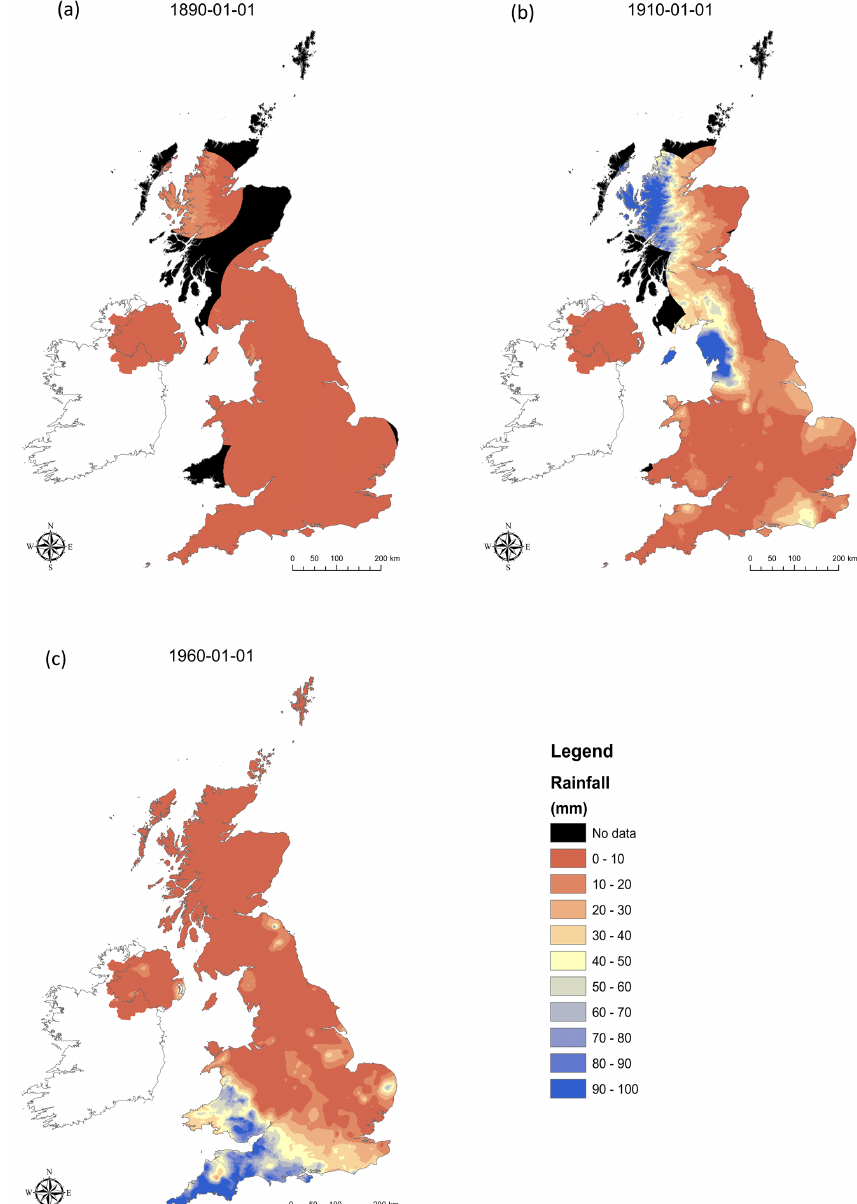
Figure 6. Rainfall map showing missing data (in black) (a) on 1 January 1890, (b) on 1 January 1910 and (c) on 1 January 1960.